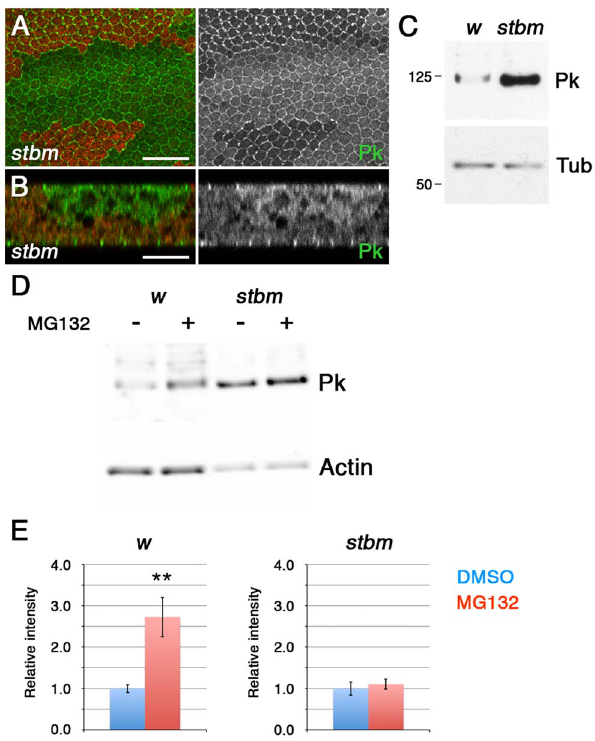
Figure 1. Stbm regulates Pk localisation and degradation. (A,B) XY (A) or XZ (B) sections of Pk staining (green) in stbm 6 clones, marked by loss of ß-gal staining (red). The XZ section shows the two apposed epithelia of the pupal wing, and the clone is only present in the top epithelium. Scale bar 20 m m (A) or 10 m m (B). (C) Western blot probed with anti-Pk showing Pk levels in w 1118 and stbm 6 28 hr pupal wings, with a -Tubulin (Tub) as loading control. Pk levels are approximately 20- fold increased in stbm 6 wings. (D,E) Western blot (D) and quantitation (E) of Pk levels relative to Actin levels, in w 1118 or stbm 6 prepupal wings treated with 10 m M MG132, or DMSO control, for 5 hr at 25 u C. Quantitation from 4 biological replicates, error bars are s.e.m., **p=0.01. driver (H.S, V.T.-M., C. Thomas and D.S., unpublished data). This